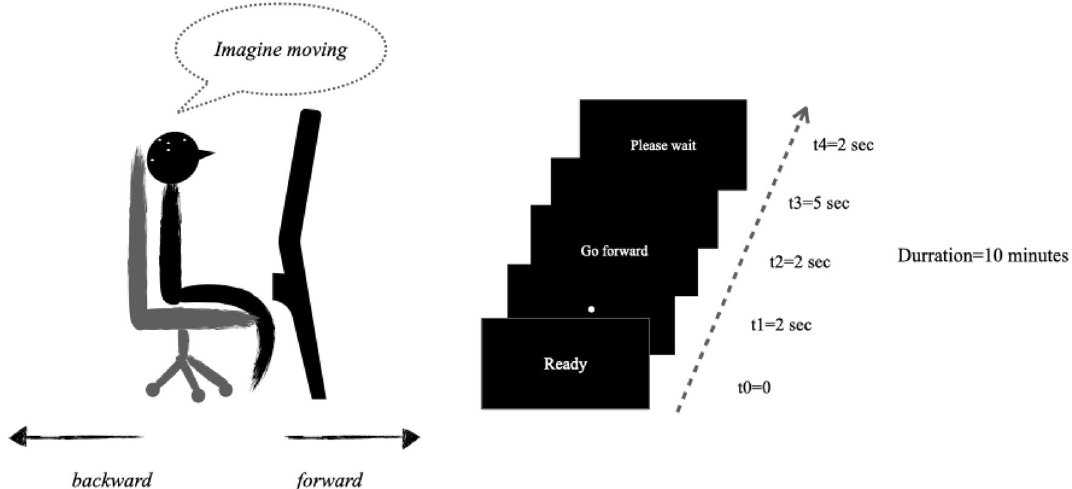
Figure 4. The participants were sitting in the same chair that s/he used for the mental preparation phase, the baseline and the training phase. Along with the training phase, each participant was adjusted in the front of an LCD screen monitor and instructed to imagine his/her own body motion when appropriate. The experimental paradigm was the same as presented in the training phase. All participants performed the mental imagery task in the dark. Participants were equipped with 32-electrode wireless EEG